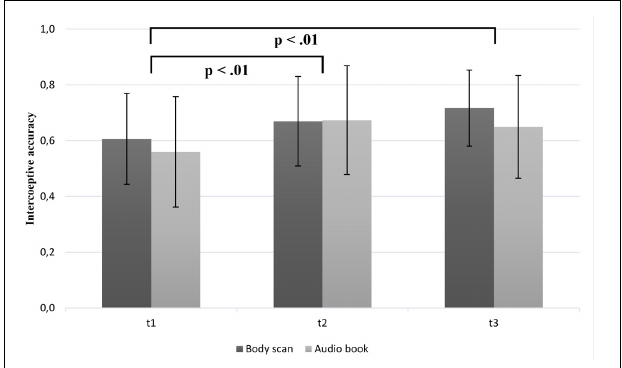
FIGURE 1 | Mean interoceptive accuracy scores as a function of group (BS vs. audio book group) and time (note: significant group differences at all time points are not marked